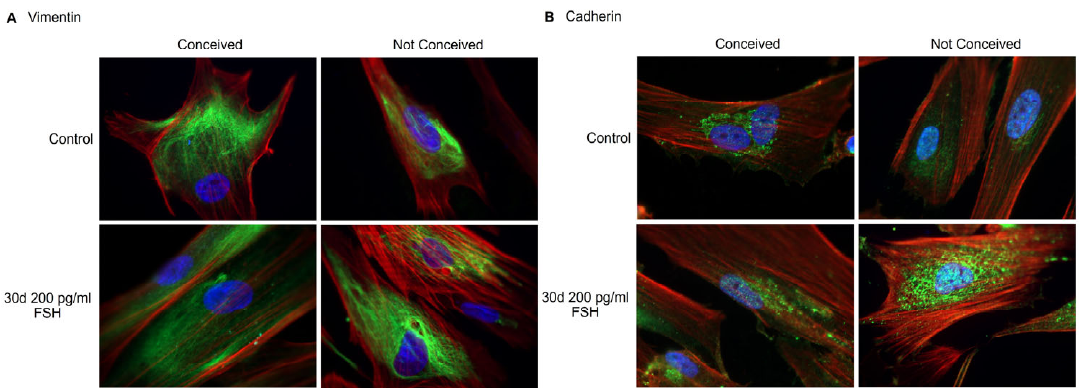
Figure 3. The levels and localization of vimentin protein ( A ) and cadherin protein ( B ) in control and 200 pg/mL FSH ‐ treated FF stromal cells on day 30 of treatment. Nuclei are stained blue, actin ‐ phalloidin is stained red, and vimentin and cadherin are stained green. Samples were analyzed using a Zeiss Axio Observer fluorescence microscope, with a 63× objective in immersion oil. Scale bar = 10 μ m.